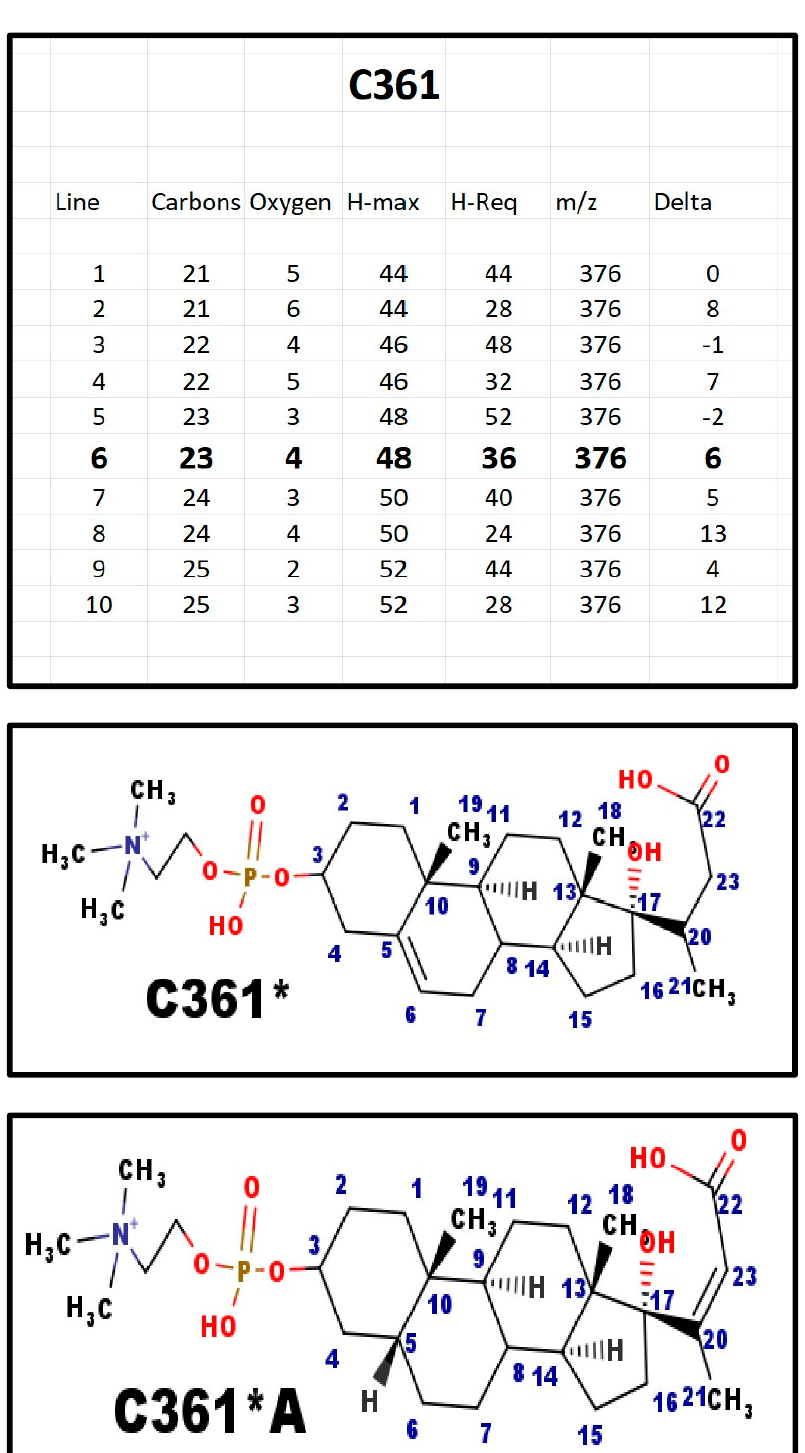
Figure A6. The proposed structures of C361.